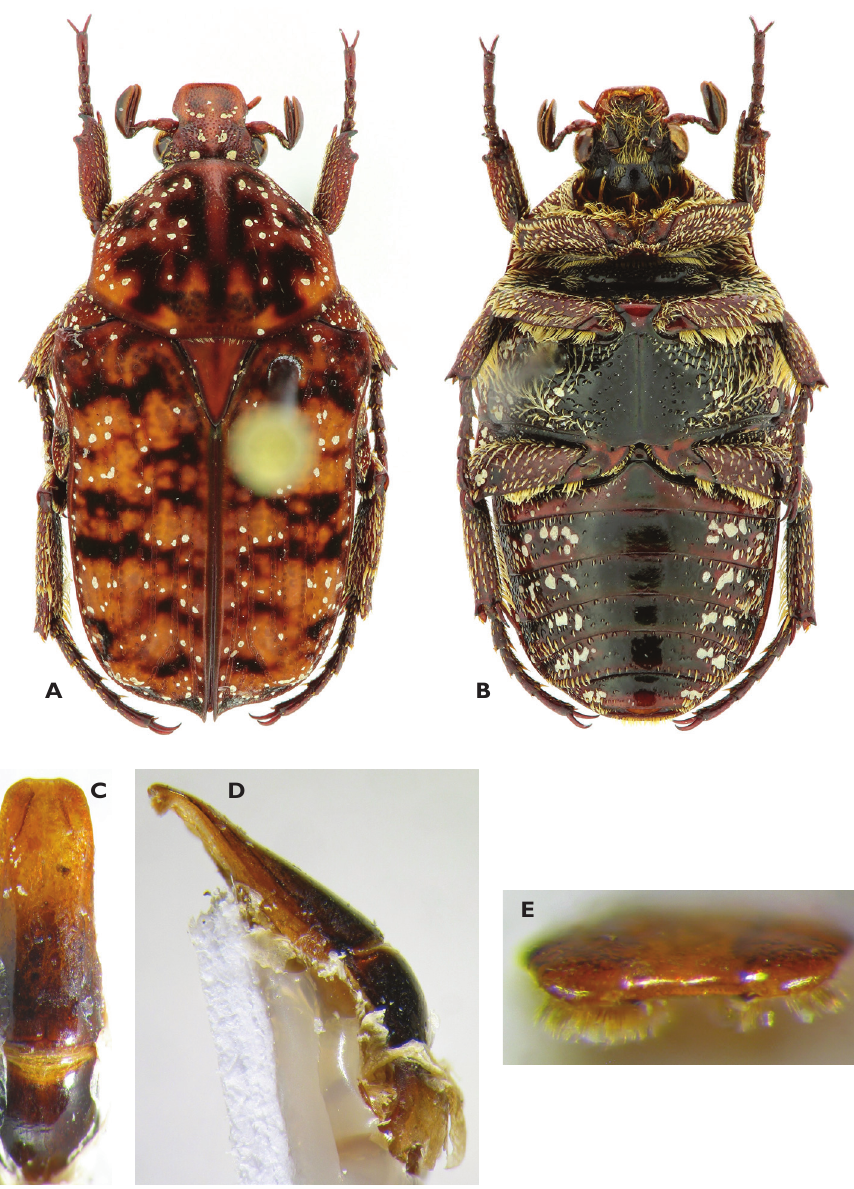
Figure 10. Atrichelaphinis ( Eugeaphinis ) deplanata minettii subsp. n., holotype (PCSR). A Dorsal view B ventral view C parameres in dorsal view D parameres in lateral view E apex of parameres.